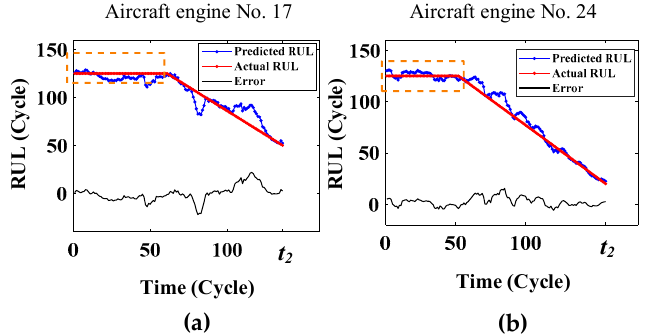
Figure 8. Part of prediction results on FD001 testing set: ( a ) Aircraft engine No. 17; ( b ) aircraft engine